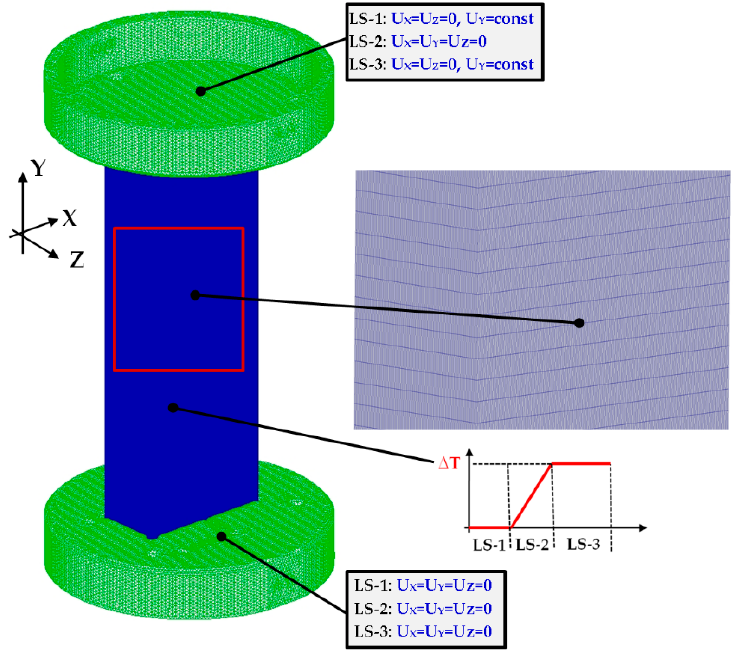
Figure 6. The discrete model FEM_SOLID with description of boundary conditions. Numerical computations were done by switching on Green–Lagrange equations for large strains and deflections and the second Piola–Kirchhoff stress as well [47]. The number of sub-steps for each performed simulation was between 500 and 1,000,000. The iteration number for each sub-step was assumed to be from 10 up to 10,000. The setting of boundary conditions and the stages related to similar conditions of the experiment. The load-step-1 denoted as LS-1 was based on the small shortening (U y ) of the columns. This allowed closing the gaps between discrete models (plates and column). The friction coefficient between all parts amounted to 0.05. The contact detection parameter was based on bias on tolerance. The separation criterion of forces was considered in calculations. The load-step-2 denoted as LS-2 involved an increase in temperature by some temperature increment. Then, both plates (upper and lower) holding the column on their external edges were unmovable (U x = U y = U z = 0). The last load-step-3 (LS-3) related to adequate compression of column at elevated temperature. The relations between the column edges and supporting plates are illustrated in Figure 7. In all simulations, initial imperfections of columns were omitted.